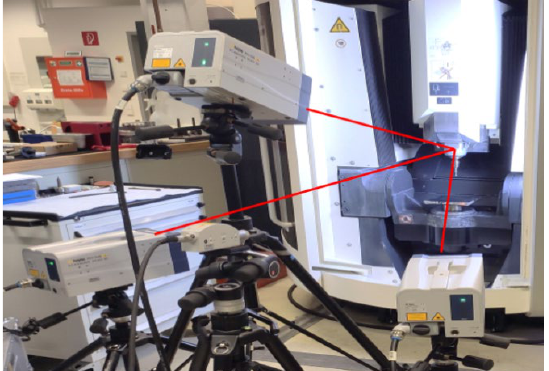
Fig. 1. Measurement setup of a Laser Doppler interferometer from Polytec